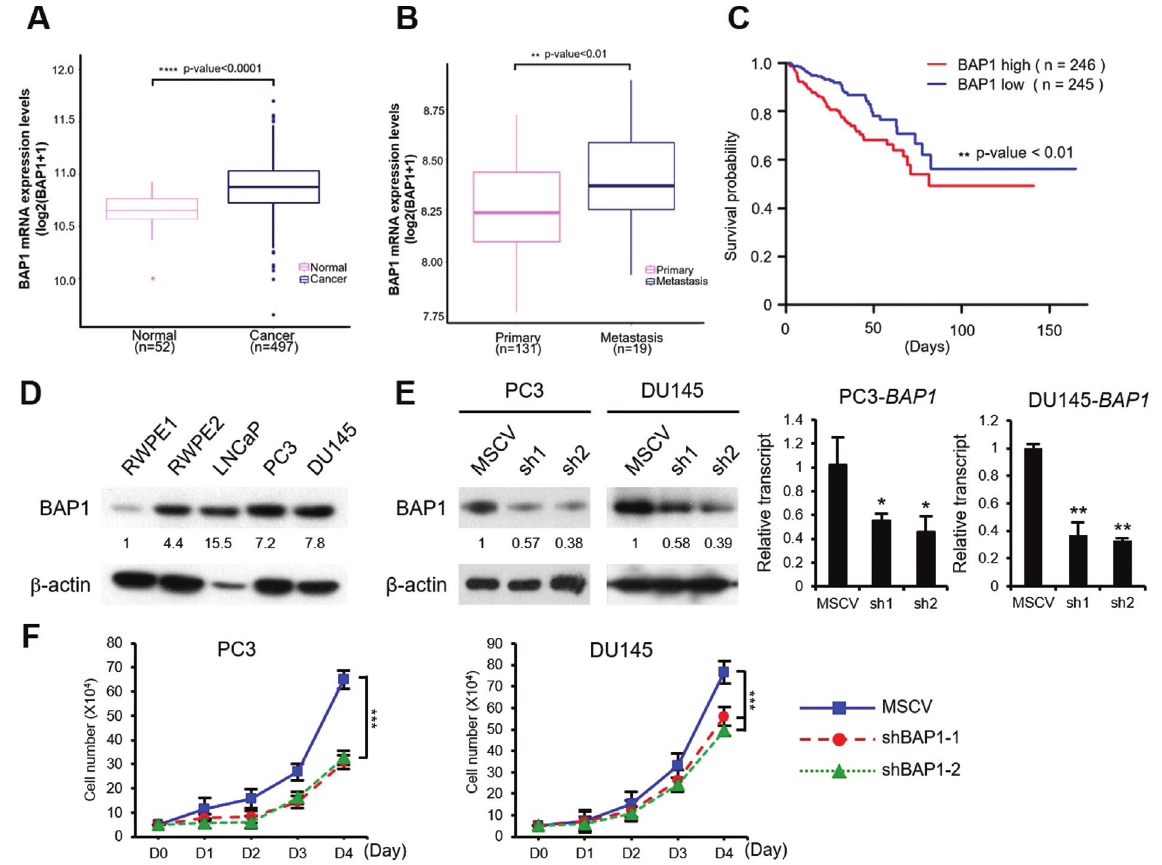
Figure 1 - High BAP1 expression is inversely correlated with disease-free survival in prostate cancer patients. (A) The expression of BAP1 mRNA in normal samples (n = 52) and cancer samples (n = 497) was compared using box-plot. The data were downloaded from the TCGA-PRAD. Significance wasassessedbyWilcoxonranksumtest(p<0.0001).(B)TheexpressionofBAP1mRNAinprimarytumors(n=131)andmetastatictumors(n=19)was compared. Raw data is available in NCBI GEO under the accession no GSE21302. The analyzed data was obtained via the cBioPortal. Statistical differ- ences were examined by two tailed Student’s t -test (p < 0.01). All statistical analyses were performed using R software. (C) Analysis of disease-free sur- vivalintheTCGA-PRADdataset.Kaplan-Meiersurvivalcurvesforhigh(n=246)andlow(n=245)BAP1expressiongroups.Eachgroupwasseparated by the median expression of BAP1. (D) The expression of BAP1 in various prostate cancer cells was analyzed by western blotting. The band density was quantified by densitometry. (E) Generation of stable BAP1-knockdown cell lines using shBAP1. Western blot and real-time RT-PCR analysis of stable BAP1-knockdown cell lines. The band density was quantified by densitometry. (F) Cell growth curves of BAP1-knockdown cell lines. Viable cells were counted by trypan blue-exclusion assay every 24 h after cell seeding. The p values were calculated by Student’s t -test. *** p <